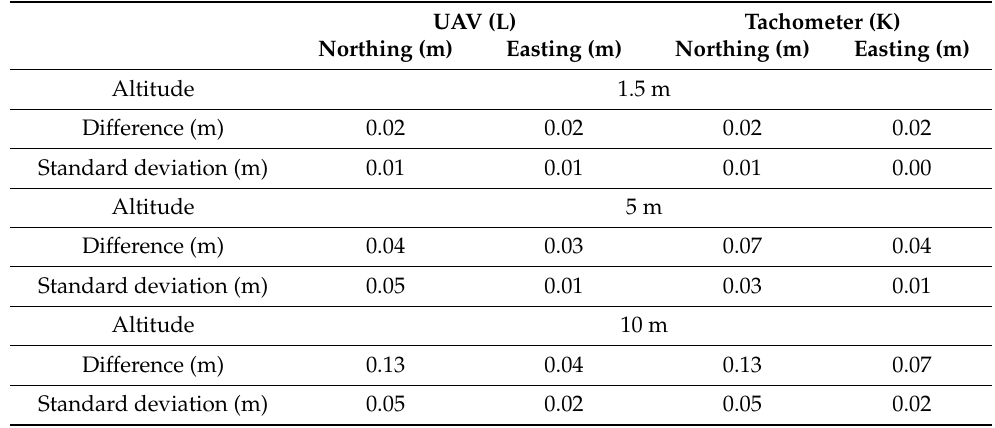
Table 4. Statistics for measured coordinates (altitude H = 1.5 m; altitude H = 5 m; altitude H = 10 m). UAV (L) Tachometer (K) Northing (m) Easting